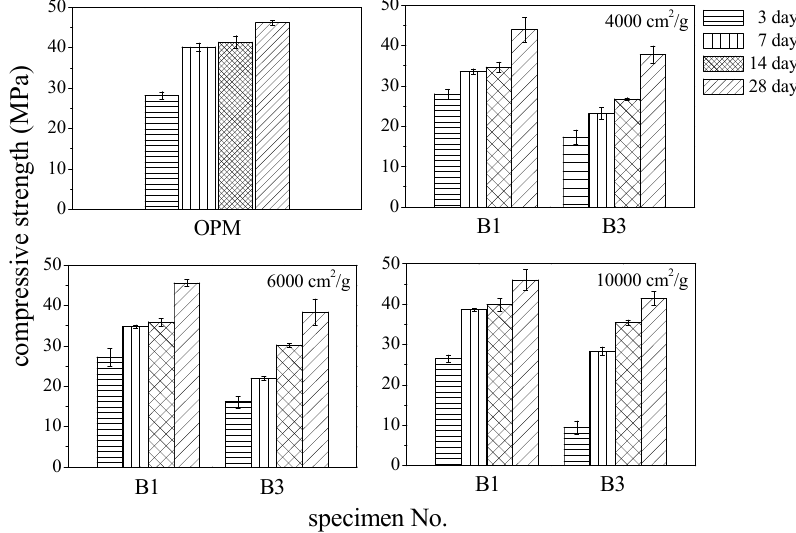
specimen No. Figure 12. Compressive strength of BOFS blended Figure 12. Compressive strength of BOFS blended mortar.